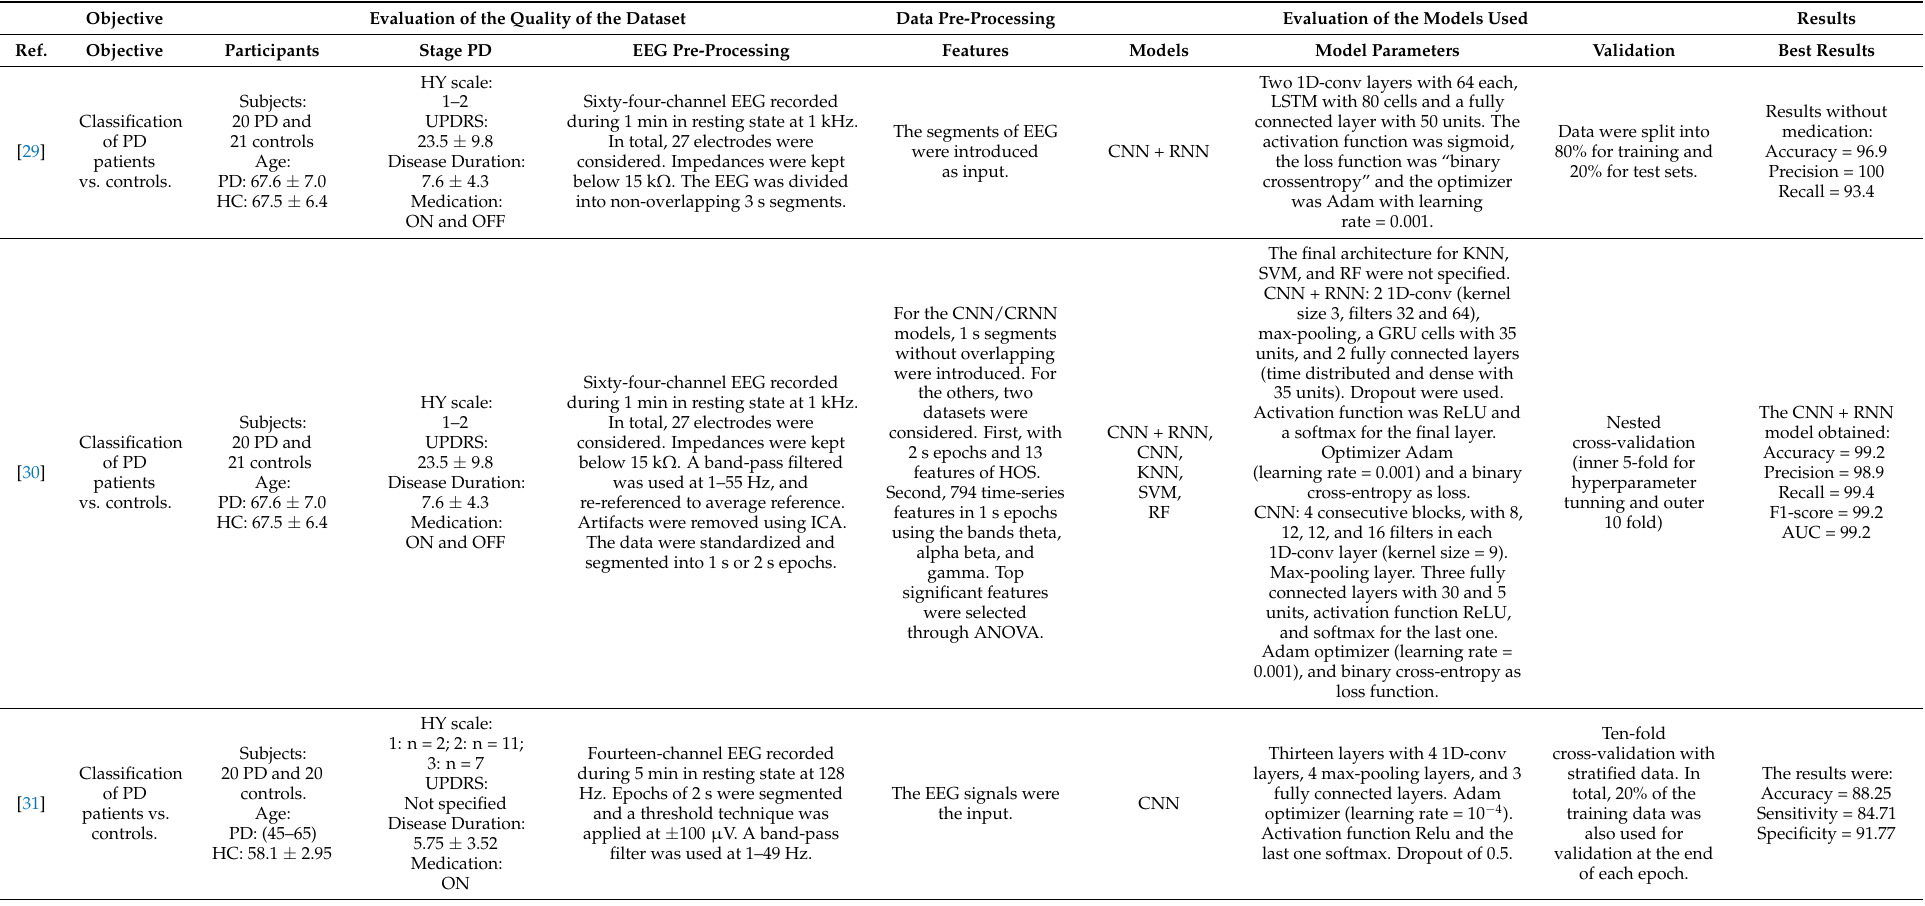
Table 3. Summary of the objectives, participants, state of PD, EEG pre-processing, features, models used, model parameters, training and validation methods, and best results for each article included in this